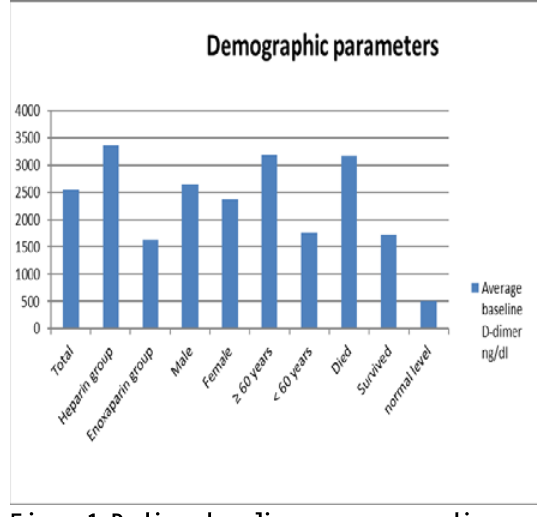
Figure 1. D-dimer baseline average according to gender (male, female), age, and final status. Table 3. Average age of hospitalized patients who received Anticoagulants (Heparin and Enoxaparin), and the type and percentage of comorbidities for each